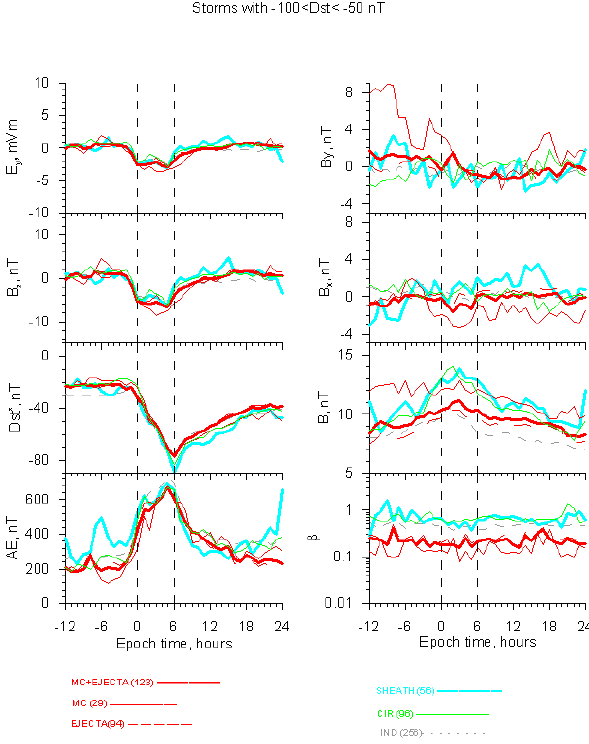
Fig. 3. The same as in Fig.1 for moderate storms with -100 < Dst < -50 nT.